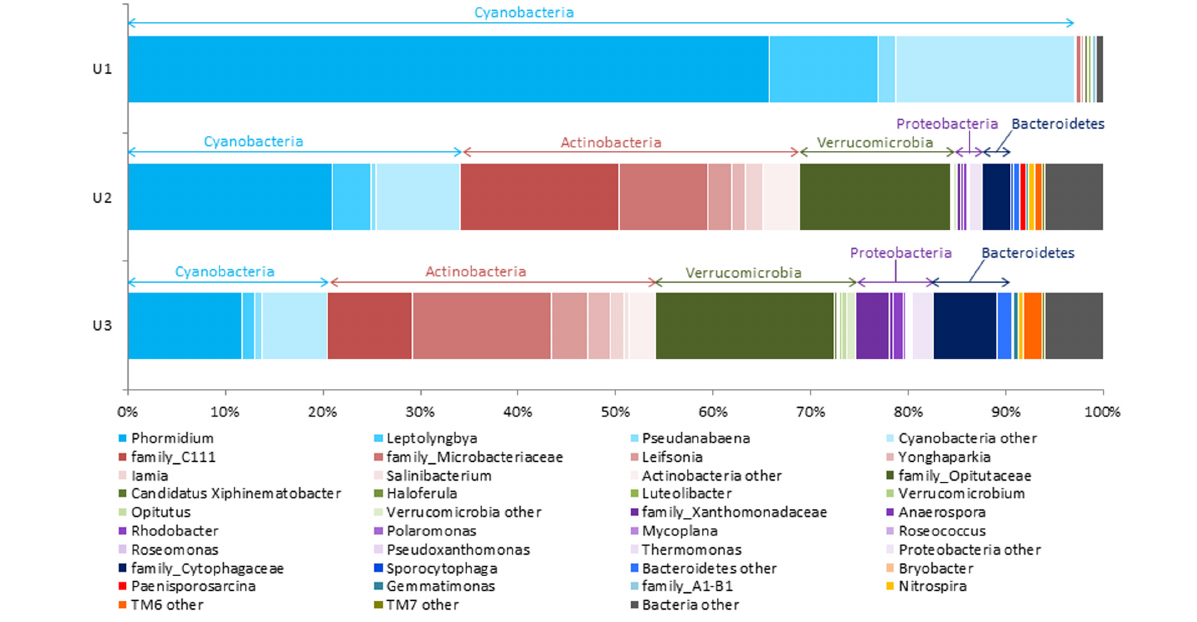
FIGURE 2 | Stacked column bar graph representing the relative abundance and distribution of the most abundant taxa up to genus level across the three laminae in this study. The figure shows that while phylum Cyanobacteria was mostly dominant in U1, the relative abundance of Cyanobacteria decreased through U2 and U3. At the highest resolution, Phormidium was found to be the most abundant taxa within the Cyanobacteria in the all laminae. The U3 had a higher abundance of Microbacteriaceae, Opitutaceae, Xanthomonadaceae, and Cytophagaceae as compared to U2, except for C111, the abundance of which was found to be decreased in U3. Sequence data analyses was performed using QIIME (v1.8.0), and the stacked column bar graph was generated using Microsoft Excel software (Microsoft, Seattle, WA, United